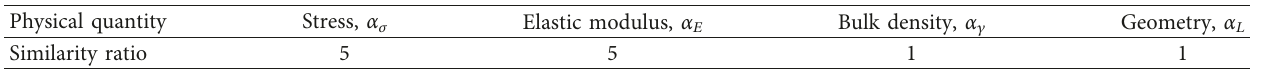
Table 6: Similarity ratios of physical quantities of simulated materials of anchor